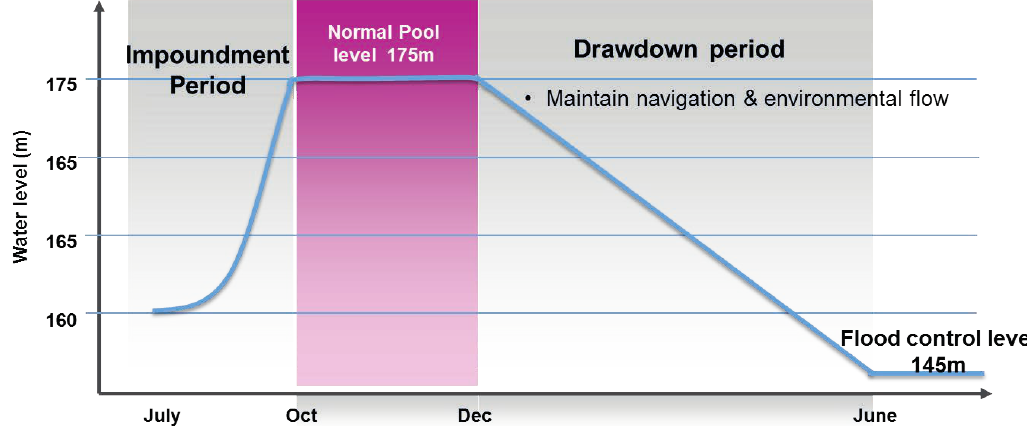
Fig. 4 Operation rules of the Three Gorges Reservoir for the hydrological circle